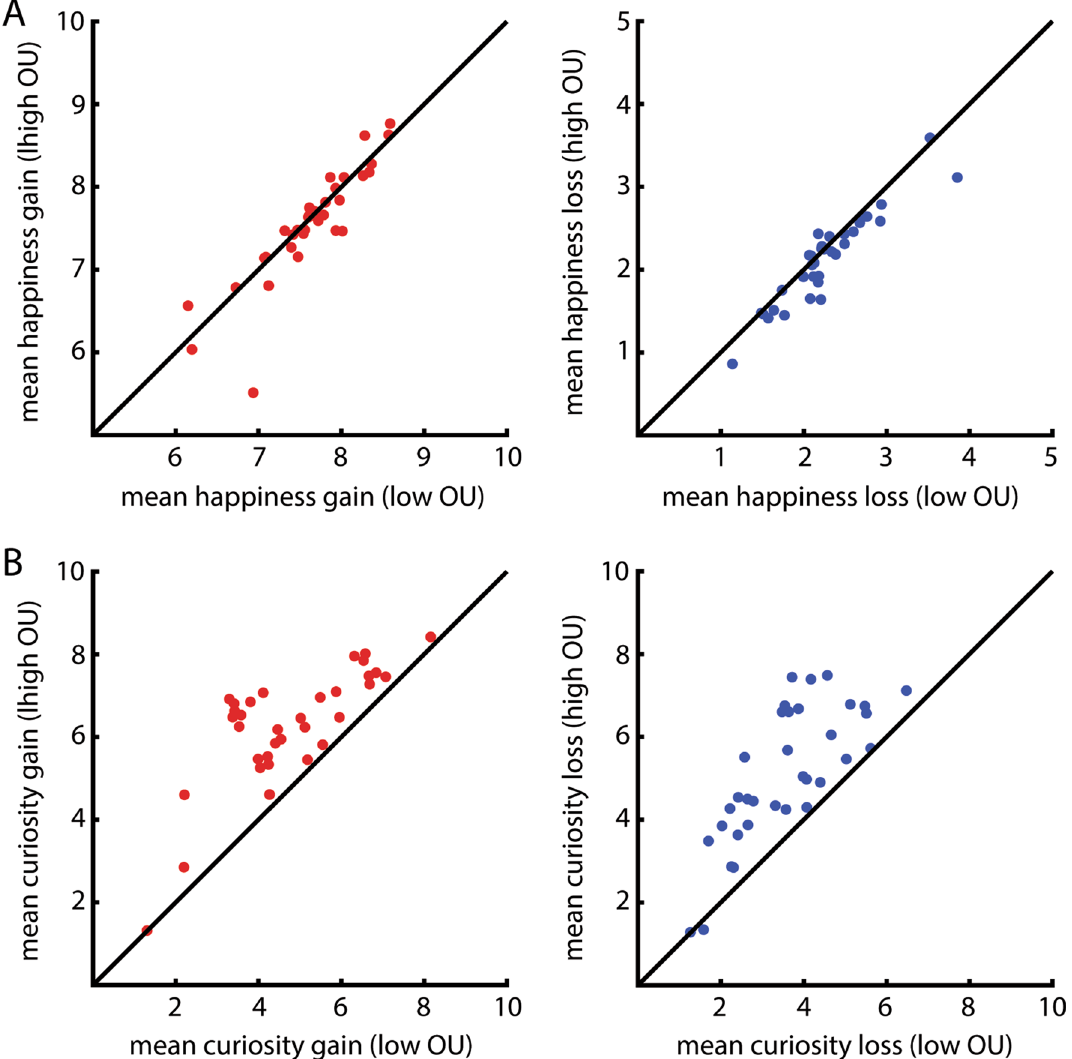
Figure 3. Individual variability in the effects of outcome uncertainty on happiness (a) and curiosity (b). ( A ) Panel A depicts individual data points representing effects of outcome uncertainty on happiness, as a function of outcome valence (left: gains in red, right: losses in blue). In both graphs, the x-axis depicts mean happiness for low outcome uncertainty and the y-axis depicts mean happiness for high outcome uncertainty. Every dot depicts one participant. The majority of the dots are below the diagonal, indicating that participants were happier when lotteries with low compared with high outcome uncertainty were played. This effect was mainly present for the loss trials (blue, right graph) and to a lesser extent for the gain trials (red, left graph). ( B ) Panel B depicts individual data points representing effects of outcome uncertainty on curiosity, as a function of outcome valence (left: gains in red, right: losses in blue). Other conventions are as for panel A. In contrast with panel A, the majority of the dots are above the diagonal, indicating that participants are more curious about the outcome of lotteries with high compared with low outcome uncertainty. This was the case for gains (left, red) as well as for losses (right,